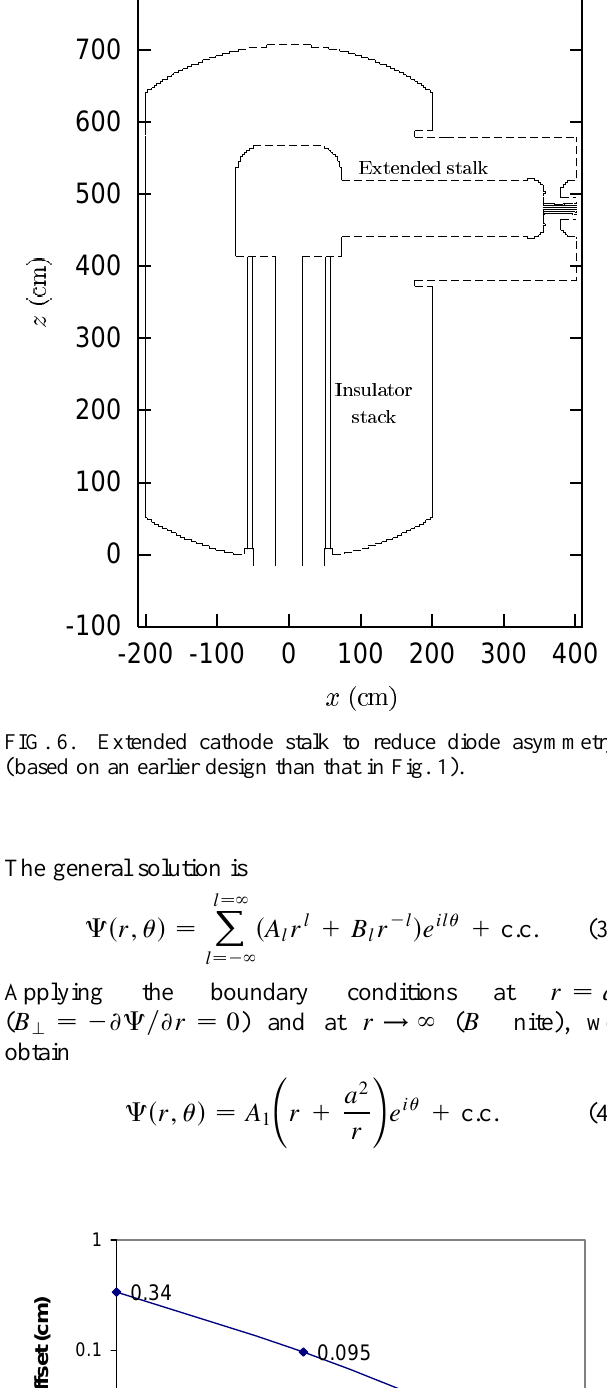
FIG. 7. (Color) Transverse offset of beam centroid 40 cm from cathode as a function of added cathode stalk length (beam current (cid:1) 4.8